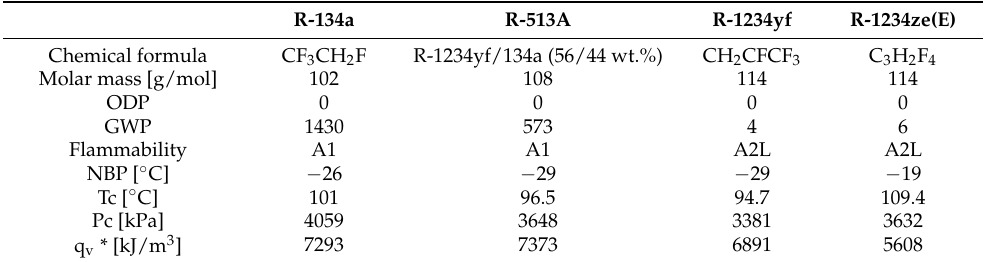
Table 1. The general properties of R-134a alternative refrigerants